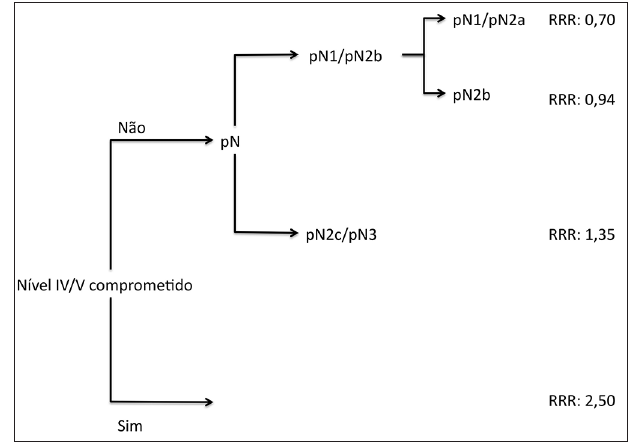
Figura 4. Gráfico da análise classificatória por particionamento recur - sivo dos pacientes (RRR: Razão de Risco Relativo). Todas as partições com p <